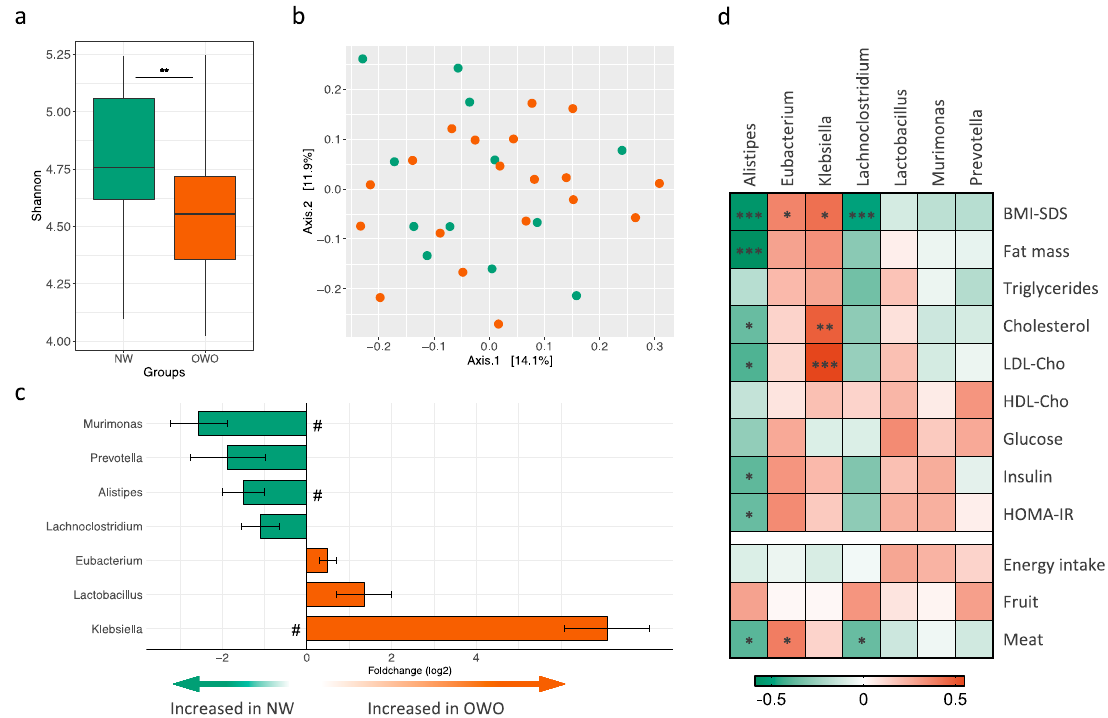
Figure 1. Gut microbiota analysis in children and adolescents with Prader–Willi syndrome. ( a ) Shannon index indicating α -diversity; significance between normal weight (NW; n = 12; green bars) and overweight and obesity (OWO; n = 19; orange bars) groups was assessed with Wilcoxon rank-sum test. ( b ) Principal coordinate analysis (PCoA) of unweighted UniFrac distances from all subjects (NW depicted as green circles, OWO as orange circles). ( c ) Fold change for genus with significantly different abundance in NW and OWO patients after Wald test; # indicates Benjamini–Hochberg adjusted p < 0.05. d ) Heatmap of Spearman correlation coefficients between genera abundance and physiologic and nutritional variables. *, p < 0.05; **, p < 0.01; ***, p < 0.005. BMI-SDS, body mass index standard deviation score; LDL-Cho, low-density lipoprotein-cholesterol; HDL-Cho, high-density lipoprotein-cholesterol; HOMA-IR, homeostatic model assessment of insulin resistance.